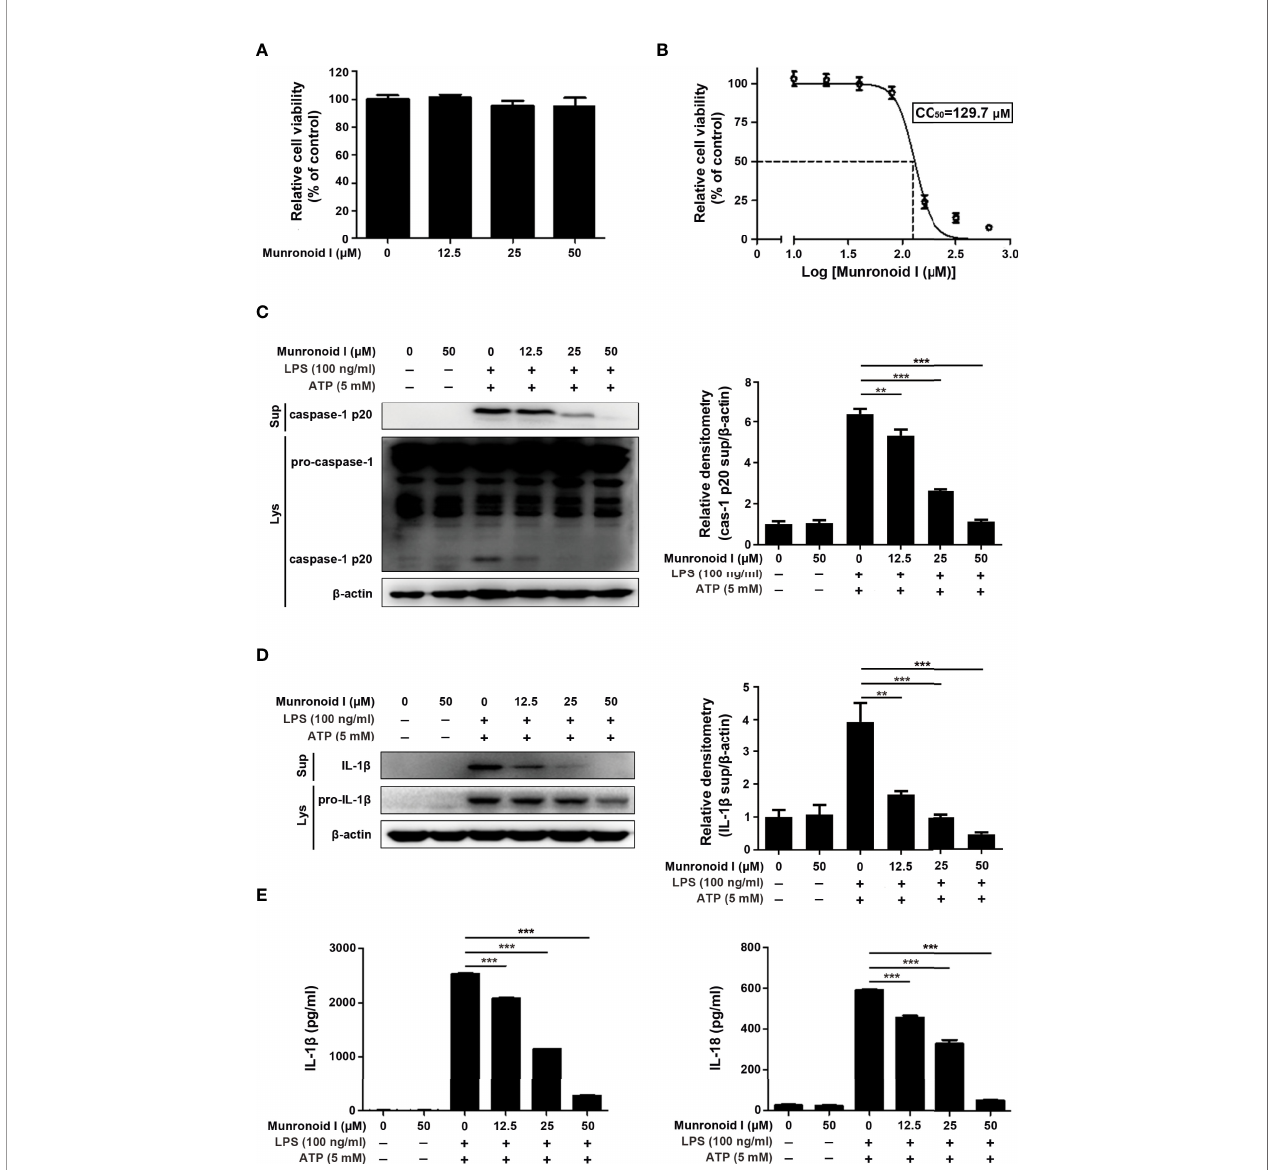
FIGURE 3 | Munronoid I suppresses the secretion of pro-in fl ammatory cytokines in LPS/ATP-stimulated macrophages. (A) Mouse peritoneal macrophages were treated with DMSO or different concentrations of Munronoid I (12.5 m M, 25 m M, 50 m M) for 24 h, the cell viability was determined by CCK-8 assay. Results presented as mean ± SD (n=5). (B) Mouse peritoneal macrophages were pretreated with DMSO or different concentrations of Munronoid I (20 m M, 40 m M, 60 m M, 80 m M, 160 m M, 320 m M, or 640 m M) for 24 h, following detected by CCK-8 assay to calculated the CC50 of Munronoid (I) (C, D) Western blot was used to detect caspase-1 (C) and IL-1 b (D) both in the cells ’ lysate and supernatants, relative densitometry analyzed by Image (J, E) The supernatants of mouse peritoneal macrophages were collected and ELISA was employed to detect IL-1 b and IL-18 production. Data in A, B, C, D, and E presented as the mean ± SD of three independent experiments. **p<0.01,